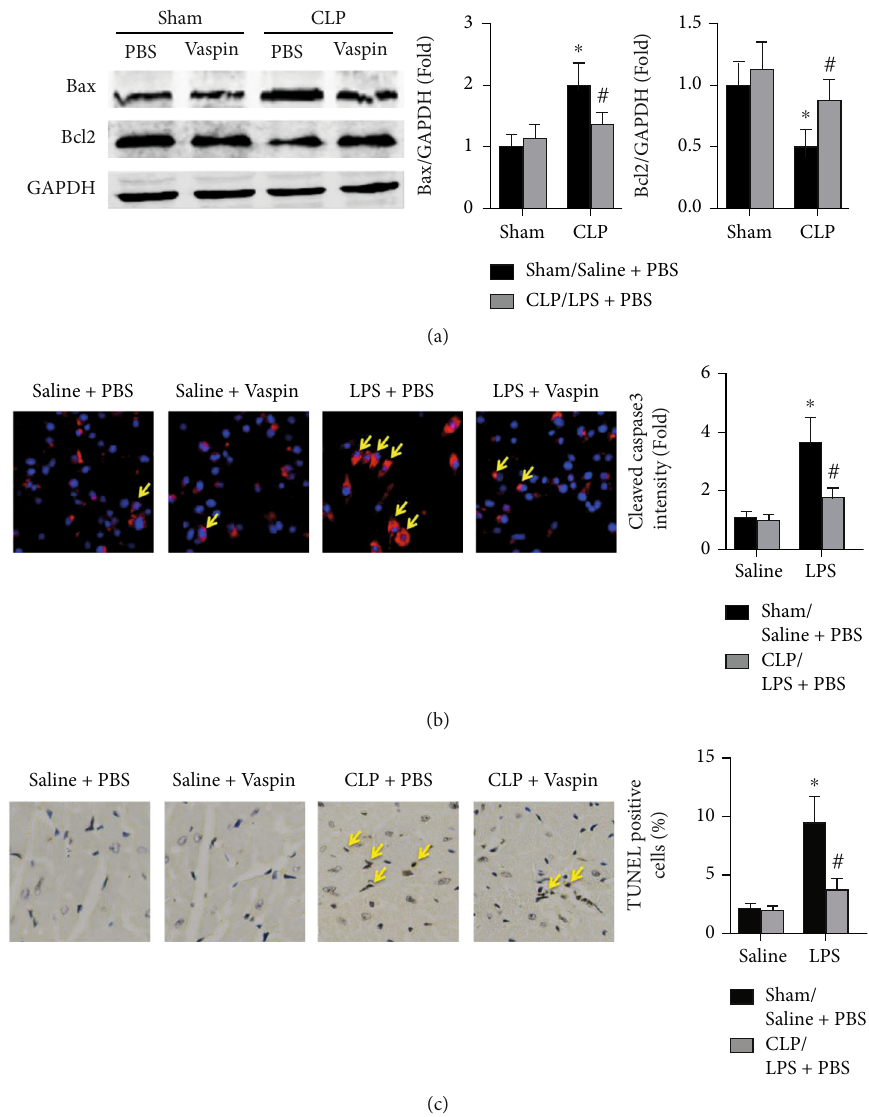
Figure 5: E ff ects of vaspin on cardiomyocyte apoptosis in septic mice. (a) Protein expression levels of cardiac Bax and Bcl2 were examined (two-way ANOVA). (b) Cleaved caspase-3 expression in LPS-induced cardiomyocytes was analyzed (two-way ANOVA). Blue and red spots indicate the nucleus and cleaved caspase3. (c) TUNEL-positive cells in each group were determined (two-way ANOVA). N = 5 in each group. ∗ p < 0 : 05 vs. the sham + PBS or saline + PBS group. # p < 0 : 05 vs. the CLP + PBS or LPS + PBS